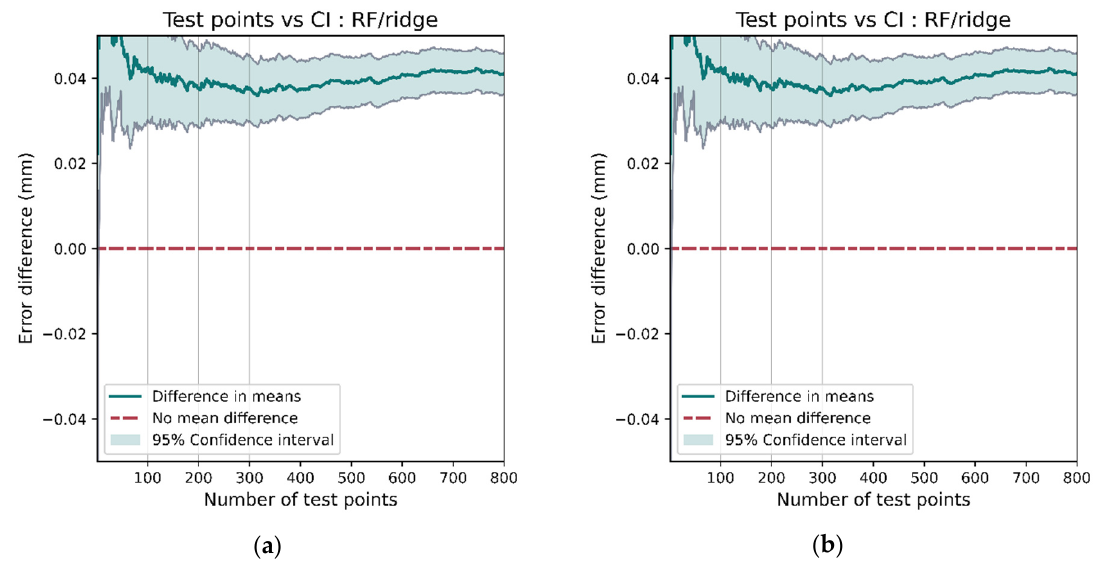
Figure 24. There is a clear difference in the performance of the RF and ridge models, shown by 0 not being contained in the 95% confidence interval ( a ) and the p -value being clearly below the 0.05 significance level ( b ).